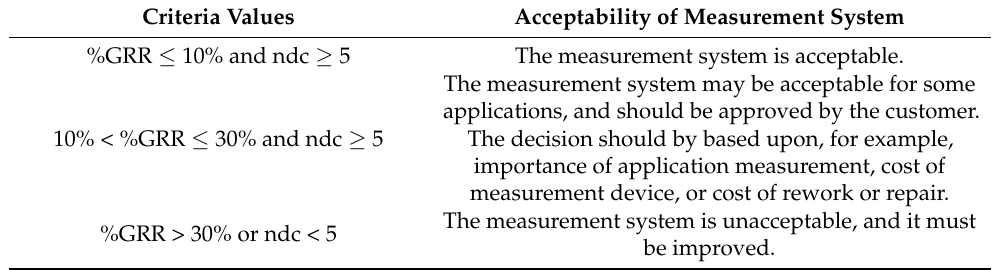
Table 1. Gage R&R analysis acceptance criteria